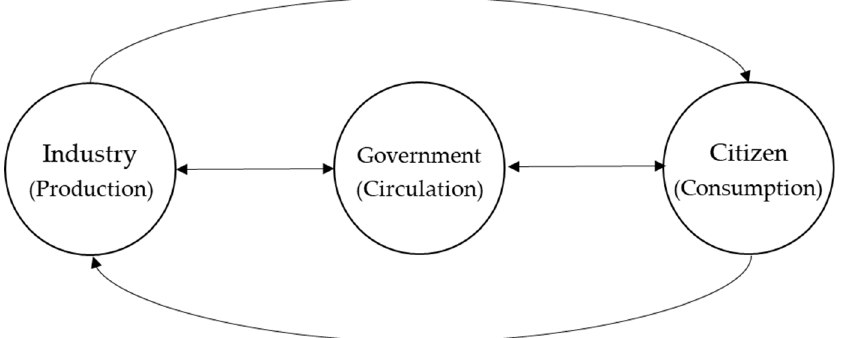
Figure 1. Fundamental elements of Smart City.